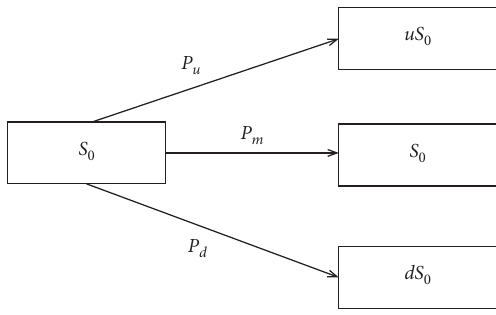
Figure 3: The basic trinomial